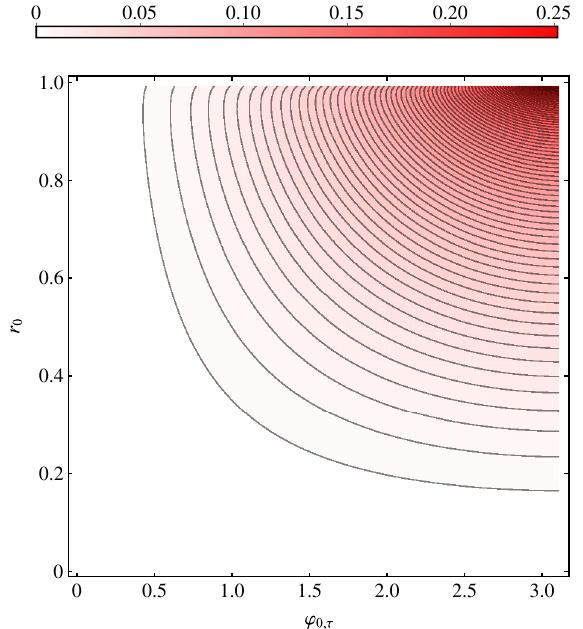
FIG. 8. The difference between the right-hand side and left- hand side of Eq. (A18) as a function of r 0 and of the relative angle φ 0 ; τ